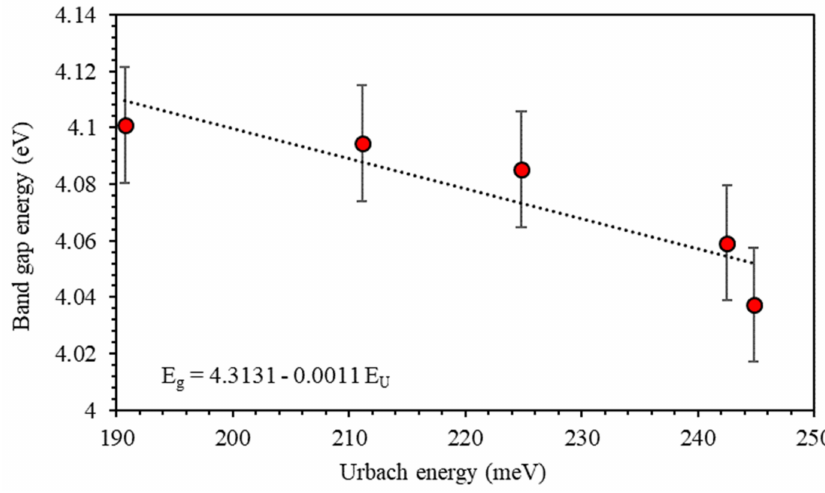
Figure 10. The relationship between the optical energy gap and the Urbach energy of PMMA– PVA/CuO nanocomposite thin films.